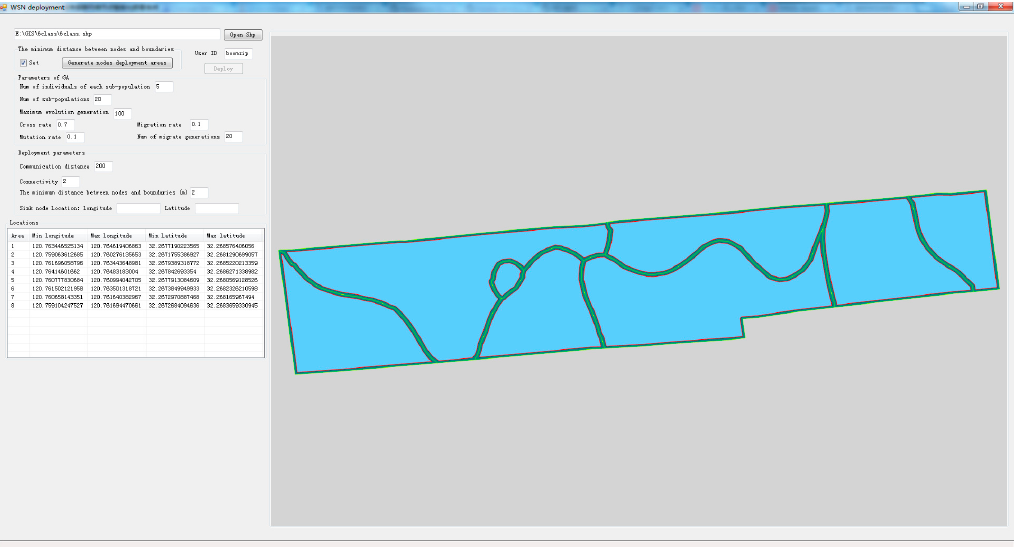
Figure 12. The interface of WSN deployment software.